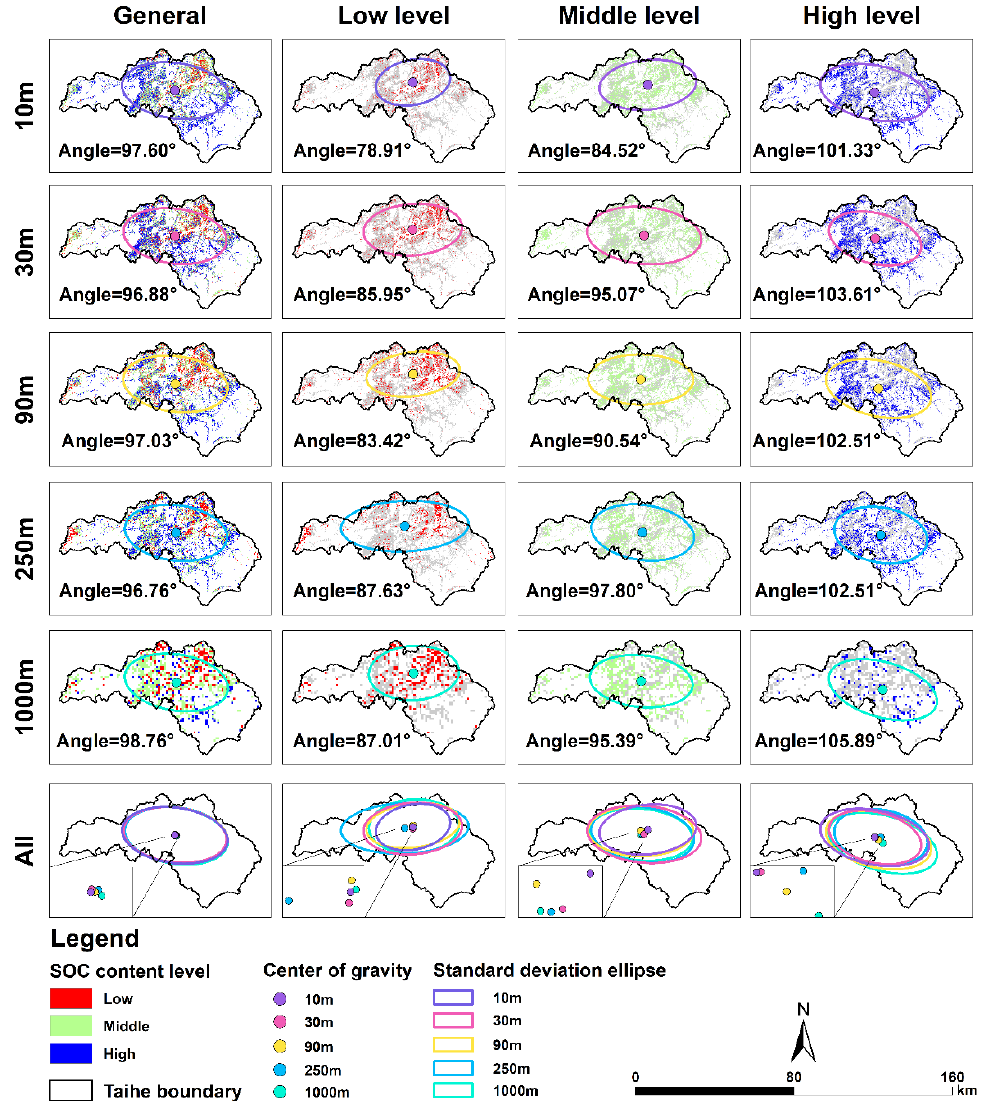
Figure 8. The standard deviational ellipses and centers of gravity of spatially predicted SOC at five different spatial resolutions for the whole, high ‐ level, middle ‐ level and low ‐ level SOC content regions, respectively.